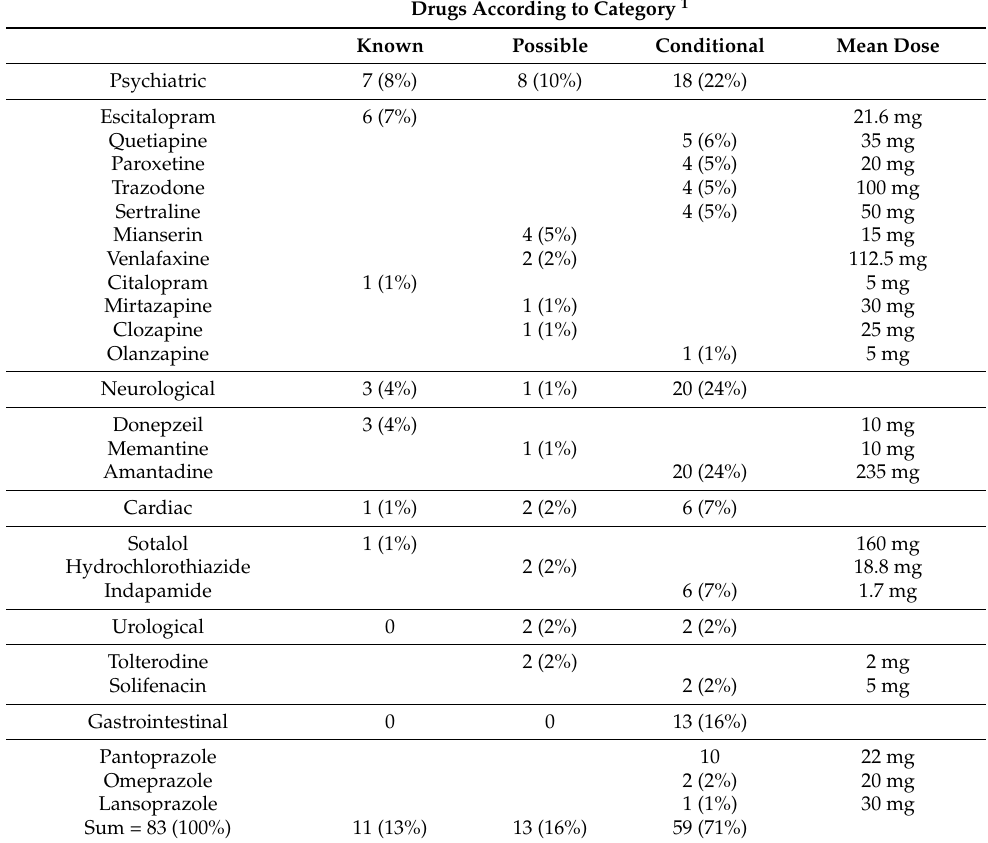
Table 2. QTc-prolonging drugs taken by studied patients according to category.